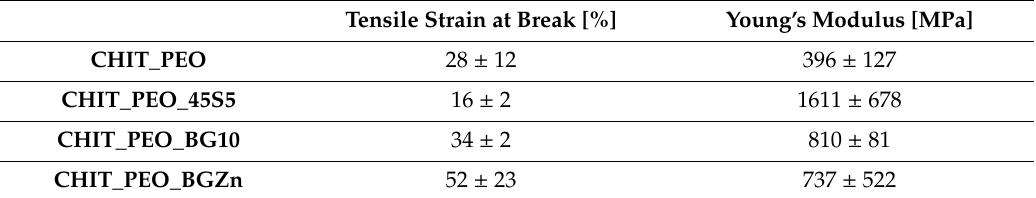
Table 4. Summary of the average of tensile strain at break and Young’s Modulus.